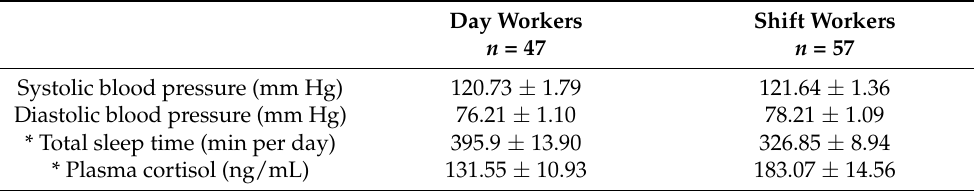
Table 2. Factors that increase risk of systemic